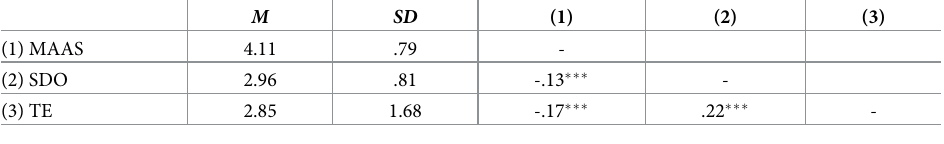
Table 1. Intercorrelations, means, and standard deviations for scores on Mindfulness (MAAS), Social Dominance Orientation (SDO), and Tax Evasion intentions